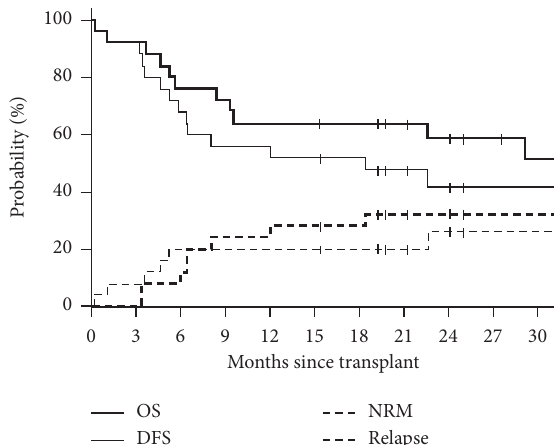
Figure 2: Survival estimates and cumulative incidence of relapse/ progression and non-relapse